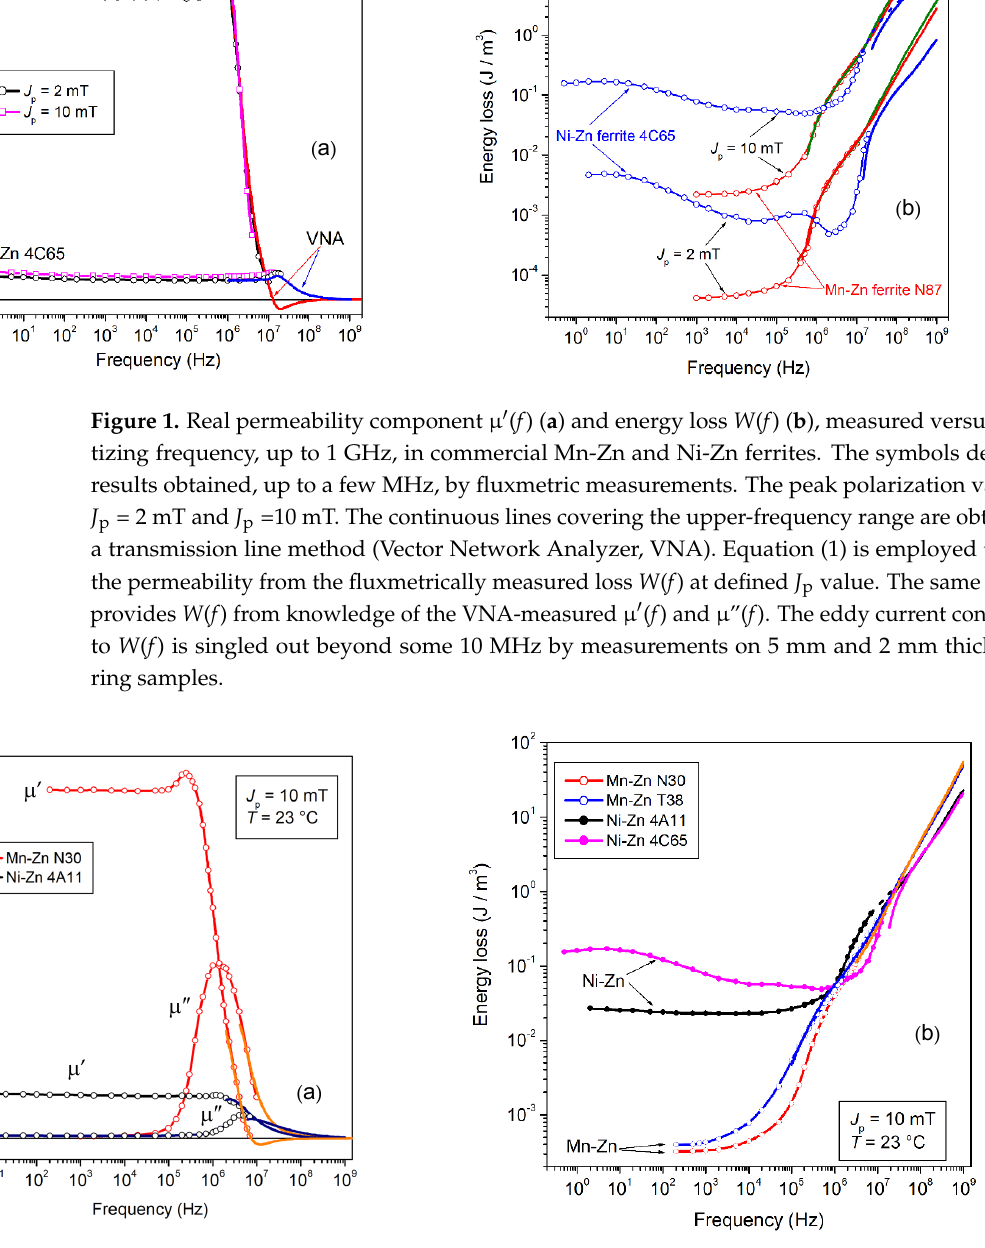
Figure 2. ( a ) Real μ′( f ) and imaginary μ″( f ) permeabilities measured up to 1 GHz at defined peak polarization J p = 10 mT (symbols: fluxmetric measurements; continuous lines: VNA measurements) in two commercial types of Mn-Zn and Ni-Zn ferrites. Their behaviors roughly comply with Snoek’s rule. ( b ) Corresponding broadband energy losses W ( f ). The Ni-Zn ferrites, while exhibiting dramatically higher losses than Mn-Zn ferrites at low frequencies, eventually display similar and eventually lower W ( f ) values upon attaining the MHz range. This points to quite different roles of dw and rotational processes in these two materials, ultimately descending from the largely different magnetic anisotropy